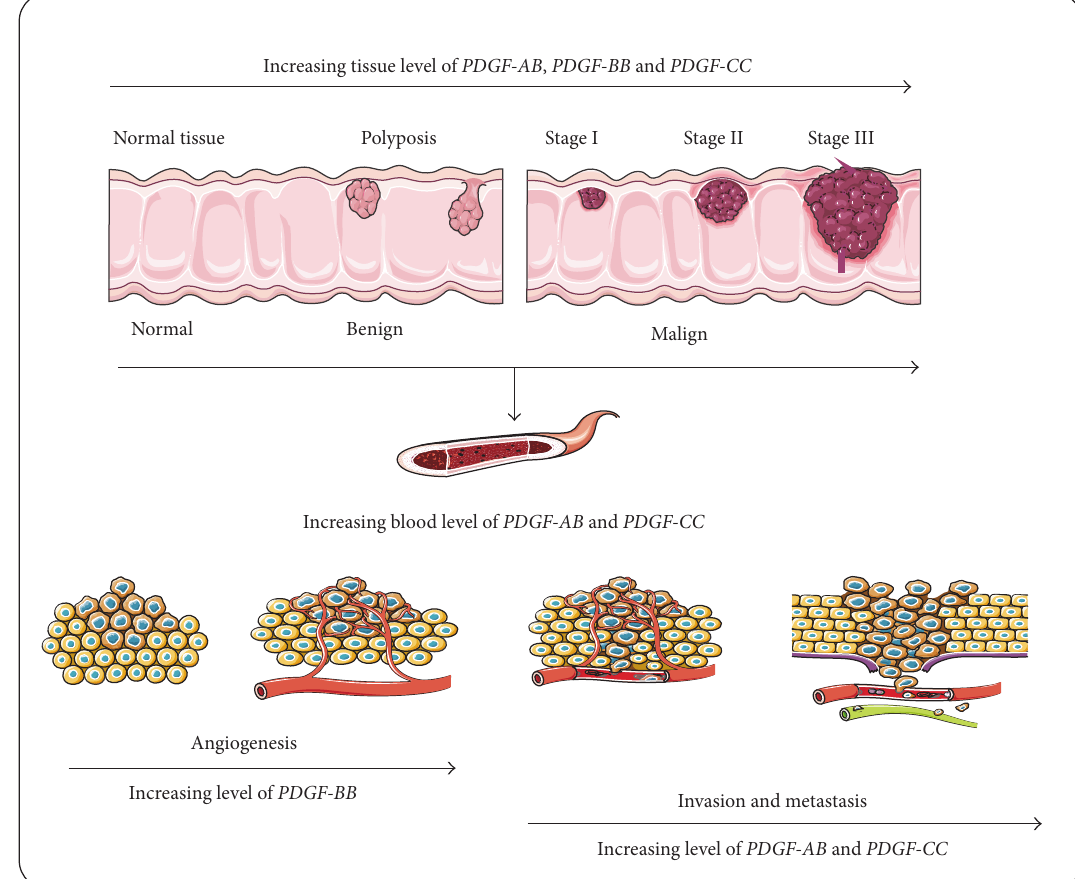
Figure 2: The role of PDGFs ligands (PDGF-AB, PDGF-BB, and PDGF-CC) in colorectal carcinogenesis. Although all three ligands are related to colorectal tissues tumors, only PDGF-AB and PDGF-CC present increased blood levels correlated with tumor stages. An increased level of PDGF-BB is correlated to colorectal tumor angiogenesis, while increasing levels of PDGF-AB and PDGF-CC are closely related to invasion and